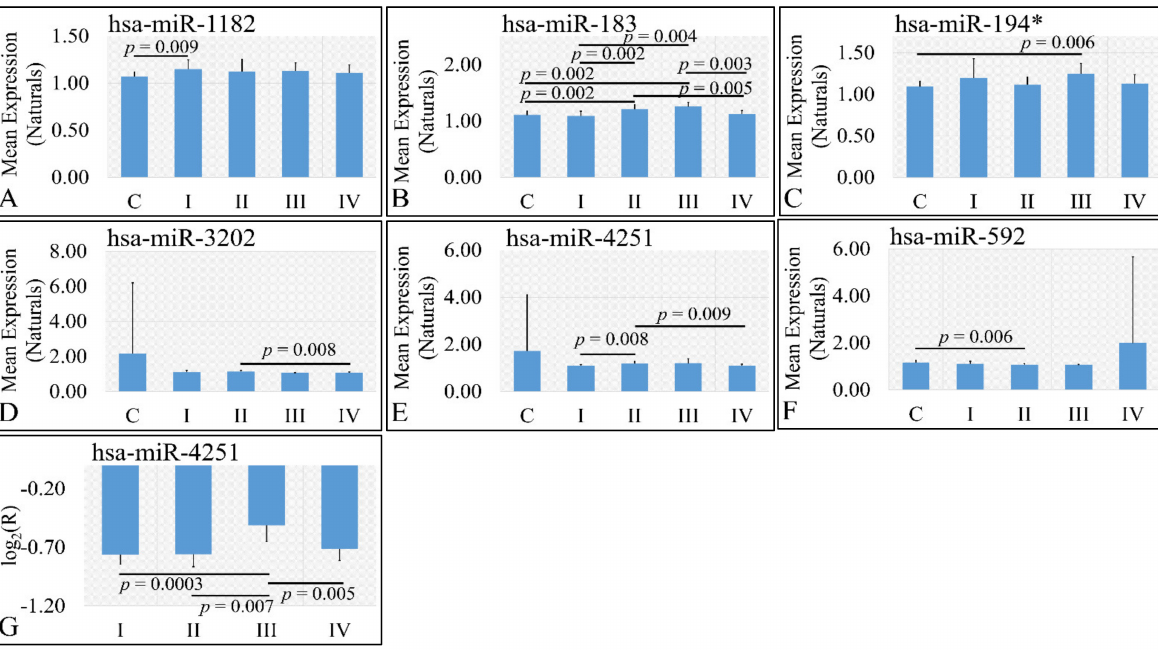
Figure 4. DE miRNAs with respect to tumor grade. Significant differences were estimated using ANOVA with Bonferroni correction. Significant differences were observed between controls and grade I ( n = 16) tumors ( p = 0.009) with respect to miR-1182 ( A ). Significant differences were observed between controls and grade II tumors ( n = 9) ( p = 0.002), between controls and grade III tumors ( n = 3) ( p = 0.002), between grade I ( n = 16) and grade III ( n = 3) tumors ( p = 0.004), between grade II ( n = 9) and grade IV ( n = 18) tumors ( p = 0.005), as well as between grade III ( n = 3) and grade IV ( n = 18) tumors ( p = 0.005) with respect to miR-183 ( B ). Significant differences were observed between controls and grade III ( n = 3) tumors ( p = 0.006) with respect to miR-194* ( C ). Significant differences were observed between grade II ( n = 9) and grade III ( n = 3) tumors ( p = 0.008) with respect to miR-3202 ( D ). Significant differences were observed between grade I ( n = 16) and grade II tumors ( n = 9) ( p = 0.008), as well as between grade II ( n = 9) and grade IV ( n = 18) tumors ( p = 0.009) with respect to miR-4251 ( E ). Significant differences were observed between controls and grade II ( n = 9) tumors ( p = 0.006) with respect to miR-592 ( F ). Finally, when including control samples, calculating the expression ratios significant differences were observed between grade I ( n = 16) and grade III tumors ( n = 3) ( p = 0.0003), between grade II ( n = 9) and grade III ( n = 3) tumors ( p = 0.007), as well as between grade III ( n = 3) and grade IV ( n = 18) tumors ( p = 0.005) with respect to miR-4251 ( G ) (Legend: R: Relative expression, where R = E tumors and E is the expression levels of controls and tumors, respectively, C: E controls